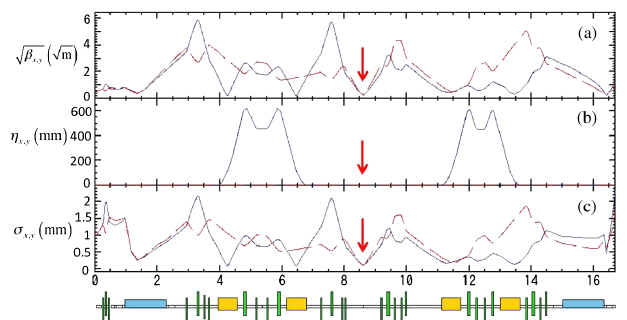
FIG. 14. Beam optics from the exit of the buncher to the exit of the decelerating structure, when interactions of the beam with the target (location indicated by red arrows) are ignored. (a) function, (b) dispersion function and (c) beam size. Blue and red lines show the horizontal and vertical planes. Blue boxes are accelerating and decelerating structures, green boxes are quadru- pole magnets, and yellow boxes are bending magnets.